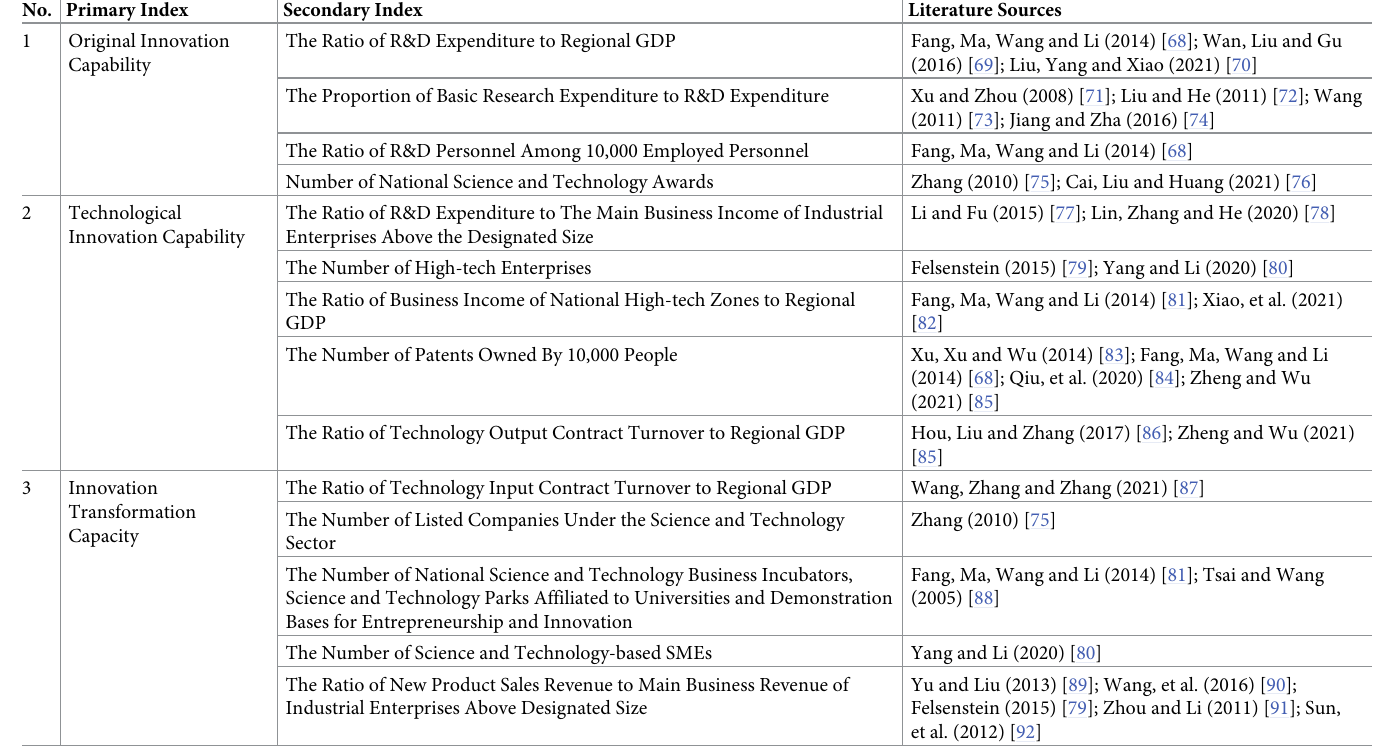
Table 1. Evaluation index system of